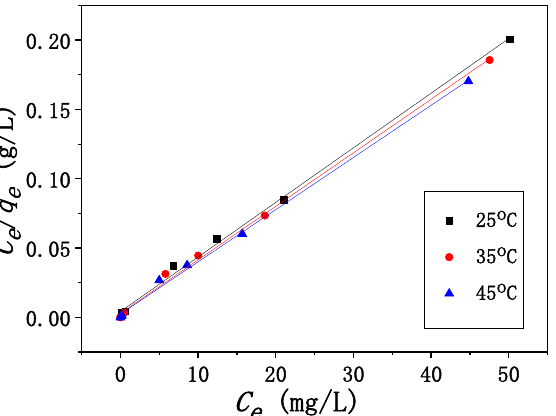
Figure 9. The fitting diagram of NiCo 2 O 4 /MWCNT isothermal adsorption model. pH, 5.0; tempera- ture, 25–45 °C; the mass of adsorbents, 0.01 g.